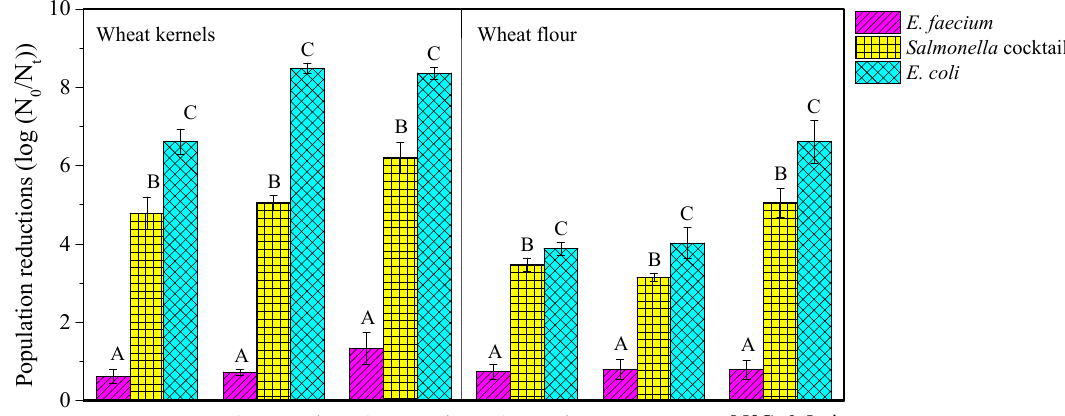
Figure 1. Population reductions (log CFU/g) of E. faecium NRRL-2356, Salmonella cocktail ( S . typhimurium ATCC 50115 and S . braederup H9812), and E. coli ATCC 25922 in wheat kernels (a w = 0.66) and flour (a w = 0.65) in different temperature–time combination treatment conditions under a fixed heating rate of 5 °C/min in the heating block system (HBS). The mean values over three replicates with the same uppercase letters are not significantly different at p > 0.05 by Duncan’s multiple comparison tests among population reductions of different bacteria strains at a fixed treatment condition.